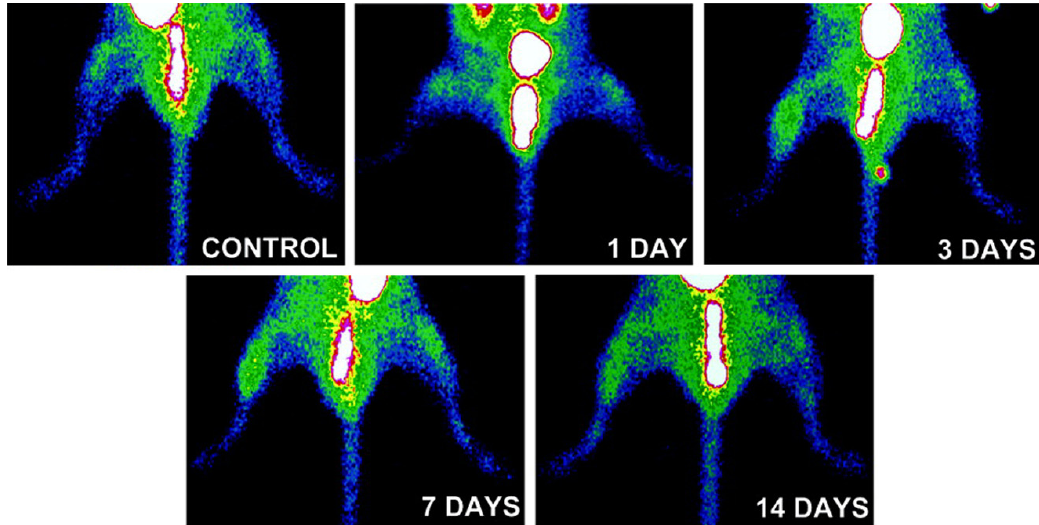
Figure 2. Integrin α v β 3-targeted imaging of hindlimb angiogenesis. Examples of in vivo α v β 3-targeted planar imaging of a control mouse (top) and mice subjected femoral artery ligation to induce hindlimb ischemia, demonstrating focal uptake of the RGD-based tracer, NC100692 is the ischemic hindlimb, maximal at 3 and 7 days after ischemia. Published with permission of Wolters Kluwer Health from “Noninvasive imaging of angiogenesis with a 99m Tc-labeled peptide targeted at α v β 3 integrin after murine hindlimb ischemia”, Hua, J., et al. Circulation 2005 , 111 (24) , 3255–3260 [43].